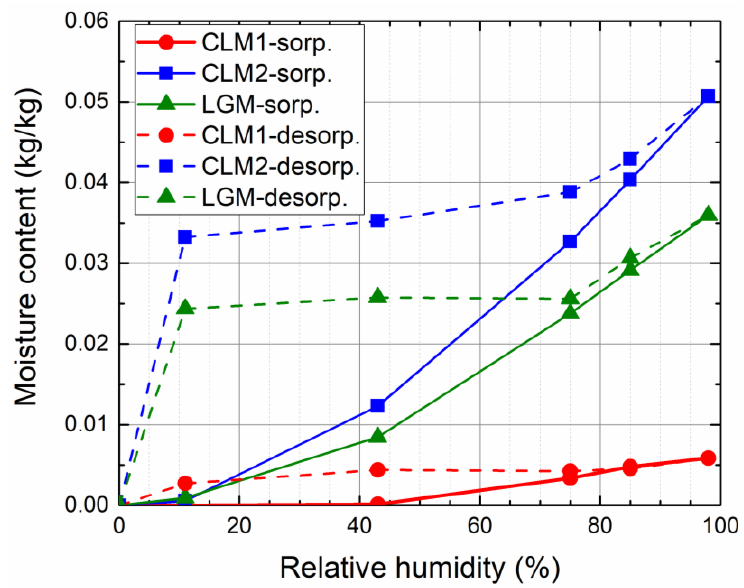
Figure 3. Sorption and desorption isotherms of the researched plasters.